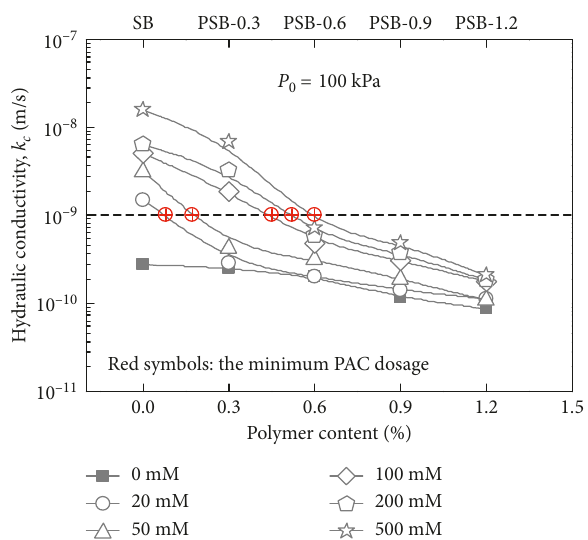
Figure 5: The correlation of k c -polymer content of backfills per- meated with Pb(NO 3 ) 2 solutions.